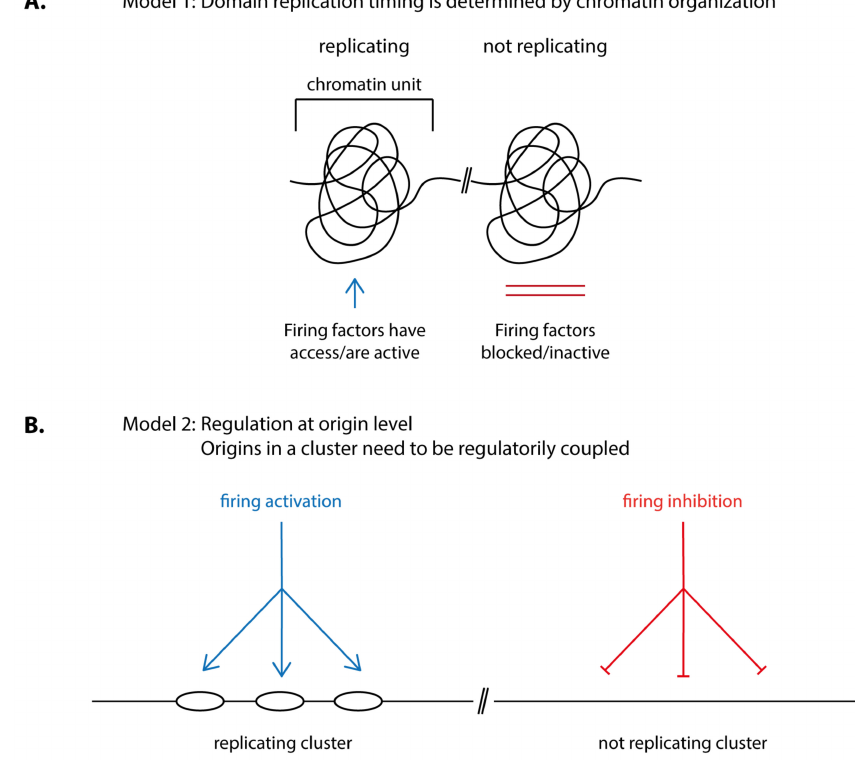
Figure 3. Two models of origin firing control to determine replication timing. ( A ) In model 1, origin firing timing is determined by chromatin organization. Different architectural chromatin units, depending on their structure, allow access/activate or block/inactivate firing factors, defining the timing of origin firing. Origins within a unit fire nearly synchronously when firing is allowed. ( B ) In model 2, origin firing timing is regulated at the origin level. This postulates that origins in a cluster fire synchronously because they are regulatorily coupled. Activating and inhibiting regulations define whether a cluster of origins fires or not at a given